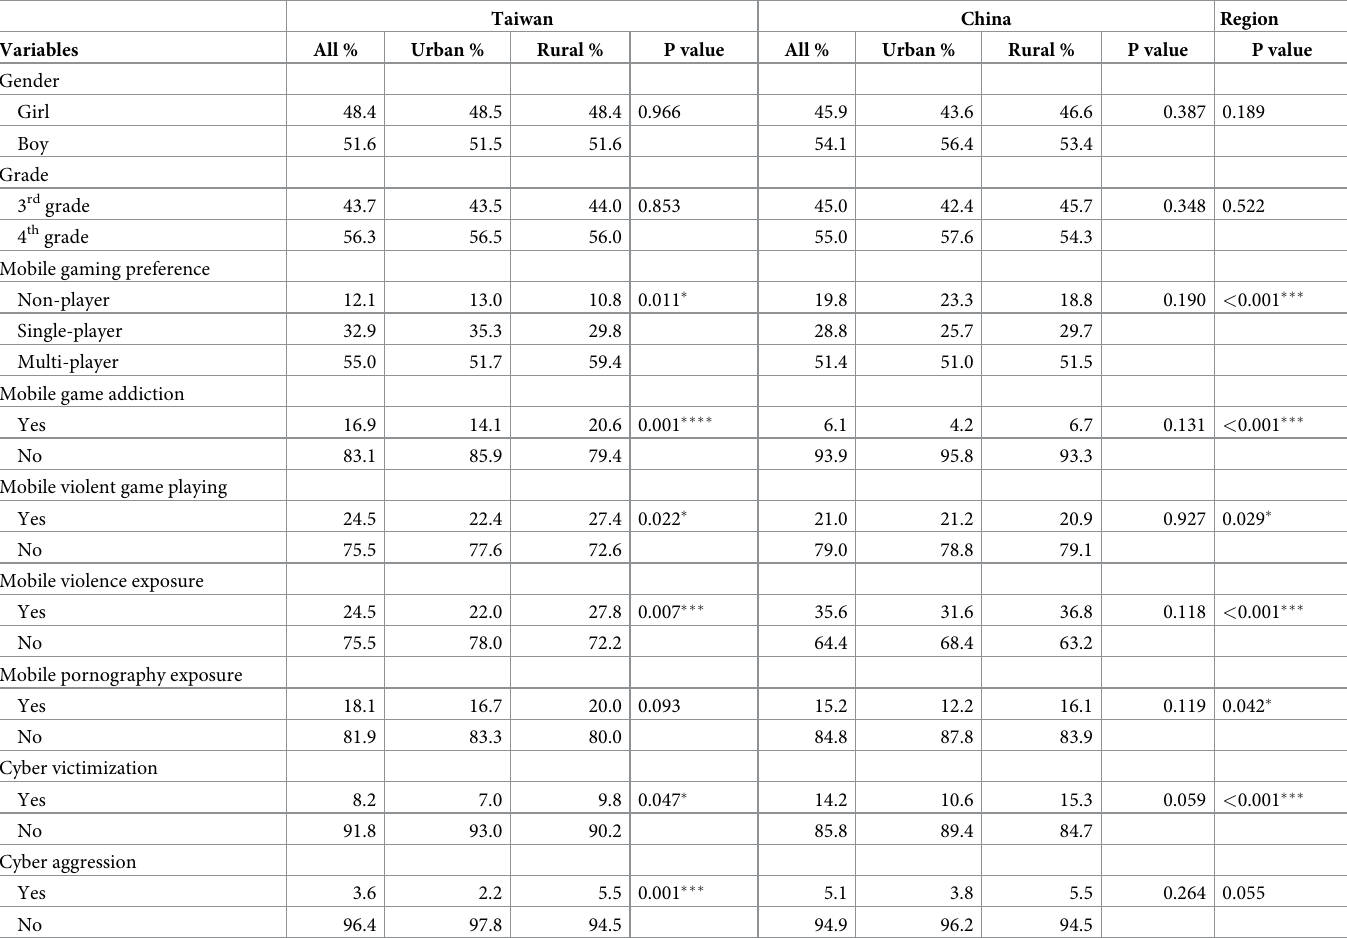
Table 1. Children’s demographic characteristics and online risks by region and urban/rural